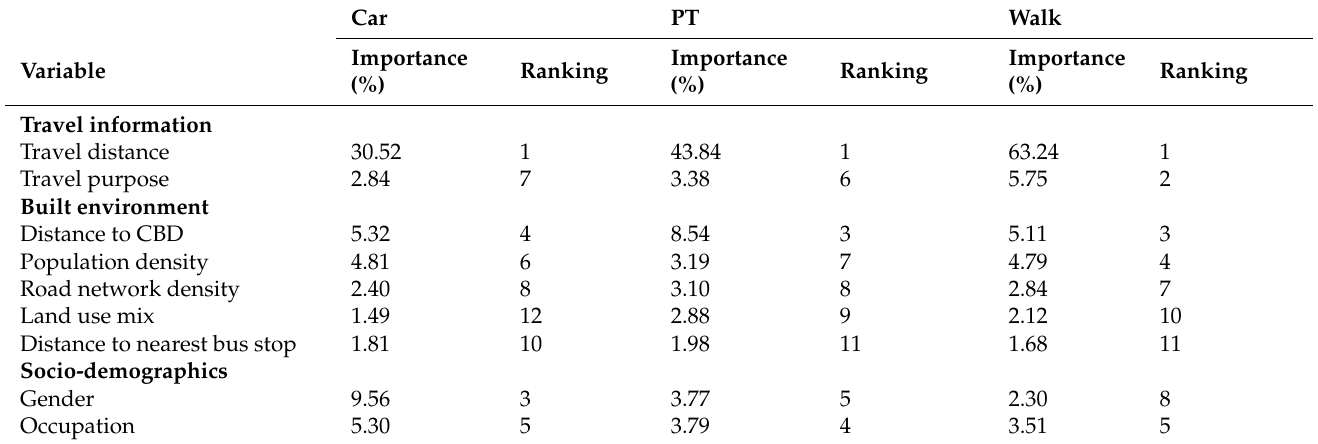
Table 4. Relative importance of variables among the three travel modes in